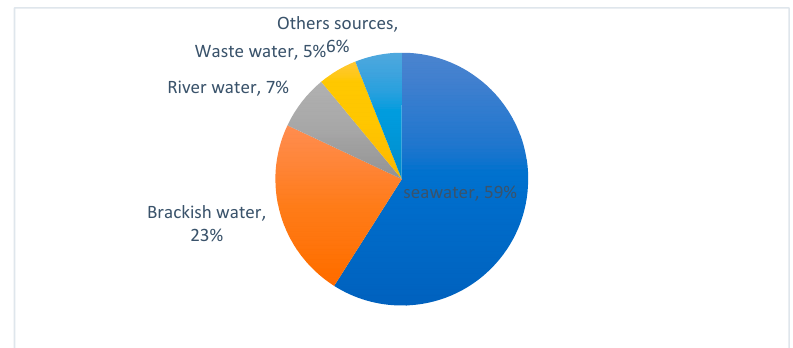
Figure 4. Participation of water sources in desalination processes. Data sourced from [57,58].